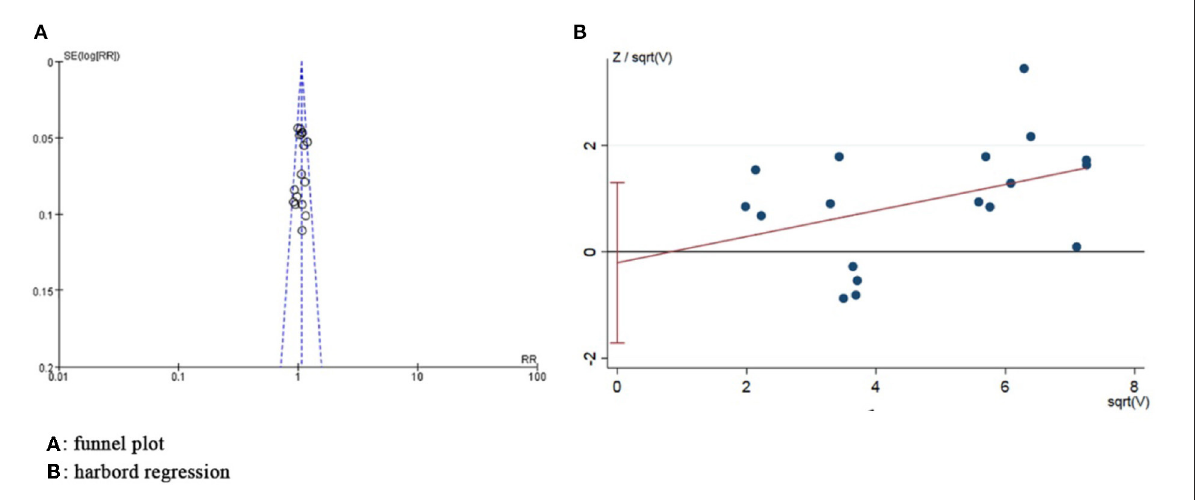
FIGURE7 Publication bias assessment